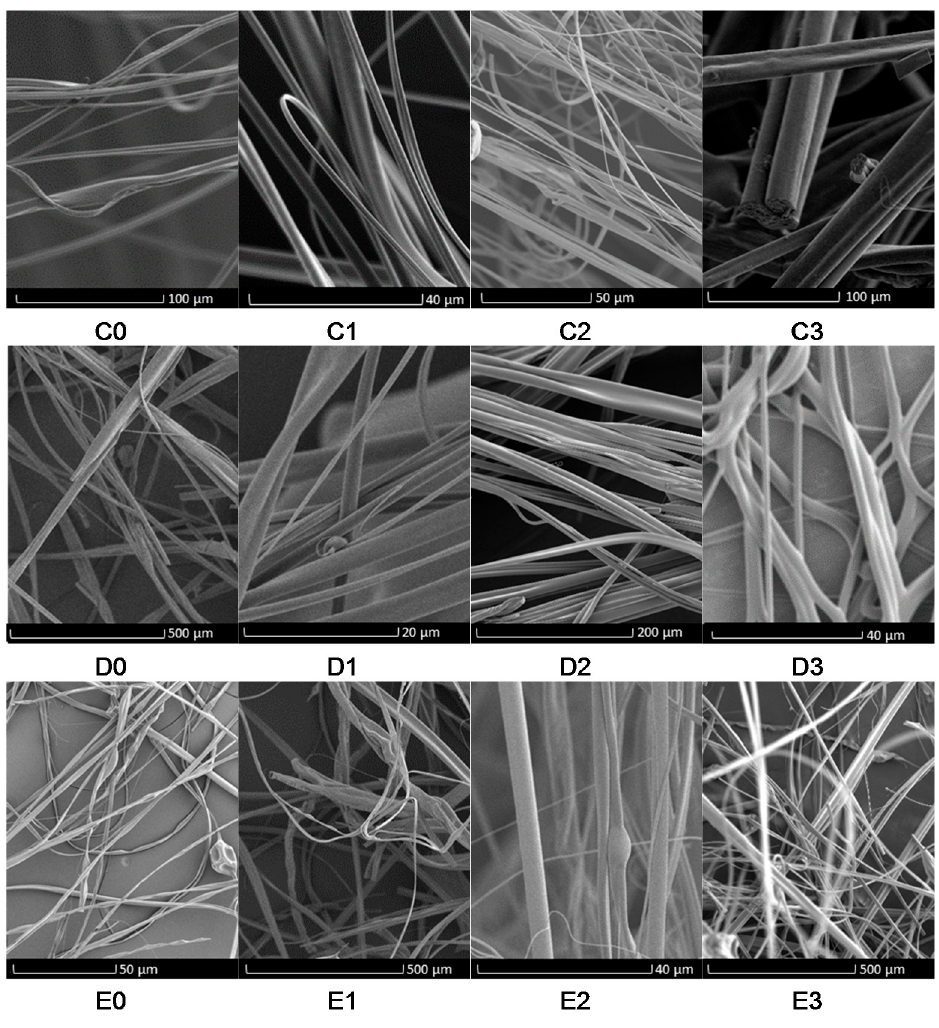
Figure 2. Scanning electron micrographs of poly(methylmethacrylate) (PMMA) fibers prepared using